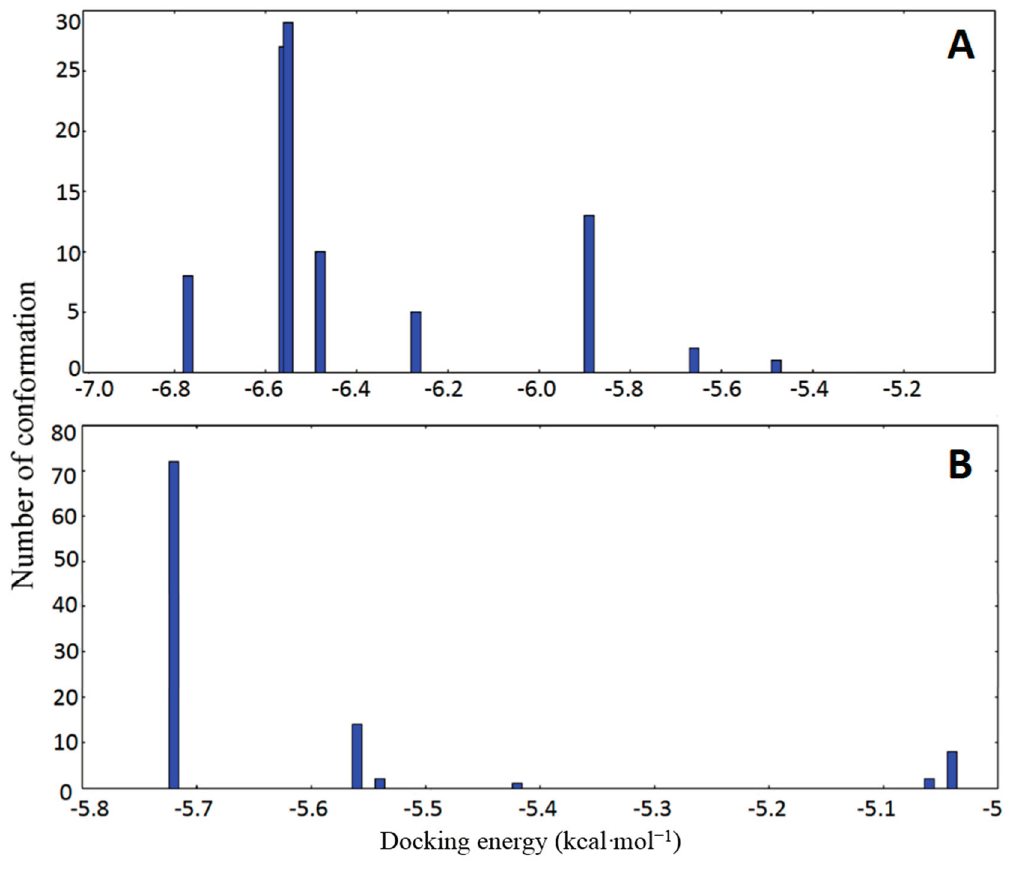
Figure 5. Cluster analyses of the AutoDock docking runs of curcumenol in the drug binding site I ( A ) and site II ( B ) of HSA